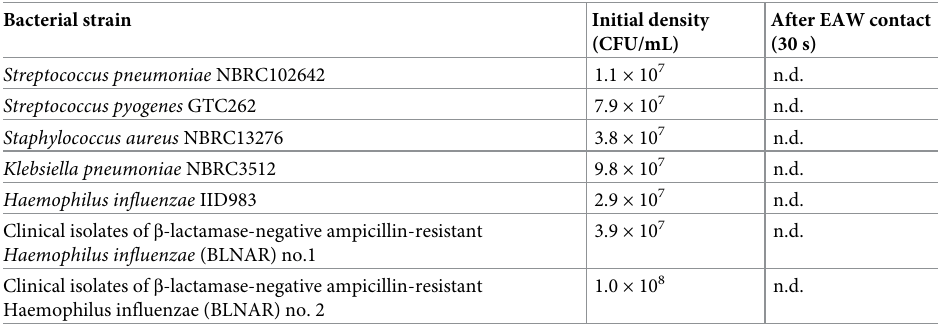
Table 4. Reduction of bacteria by